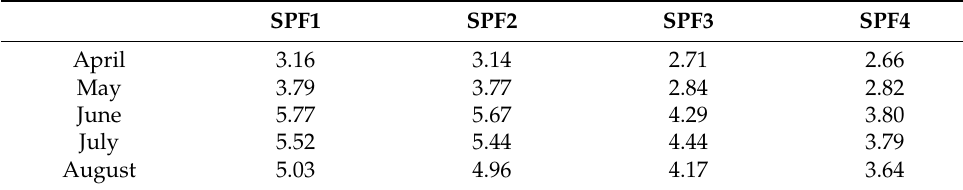
Table 5. Seasonal Performance Factors for the year